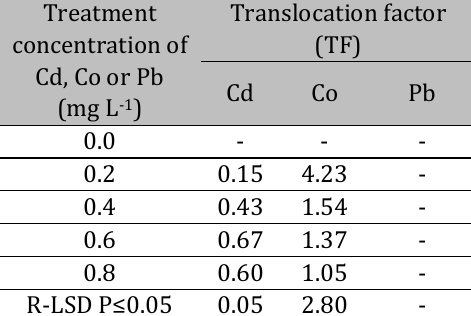
Table 4. In vitro translocation factor (TF) of cadmium, cobalt, and lead